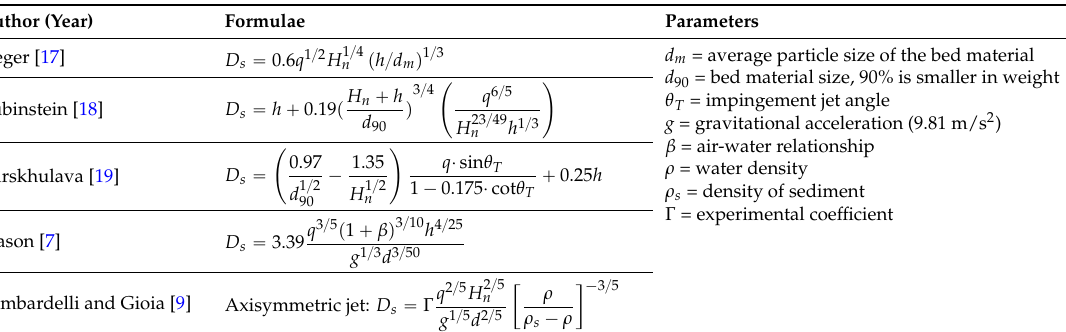
Table 3. Five general scour formulae.